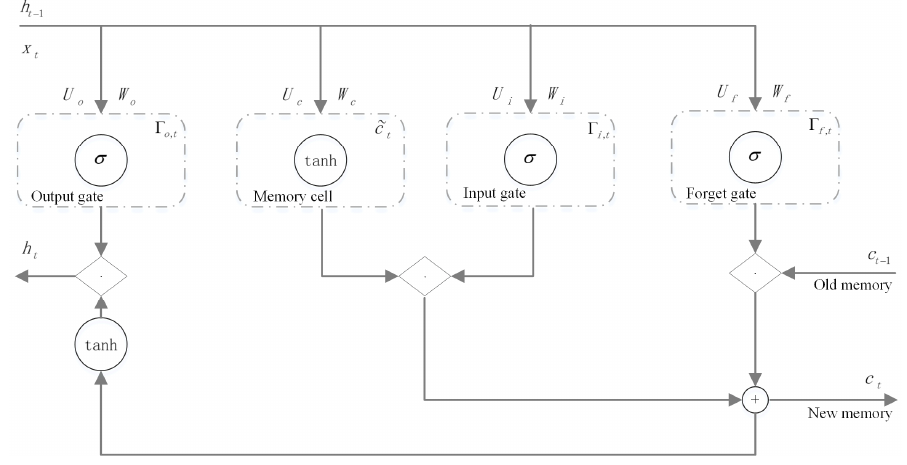
Figure 4. LSTM cell structure.